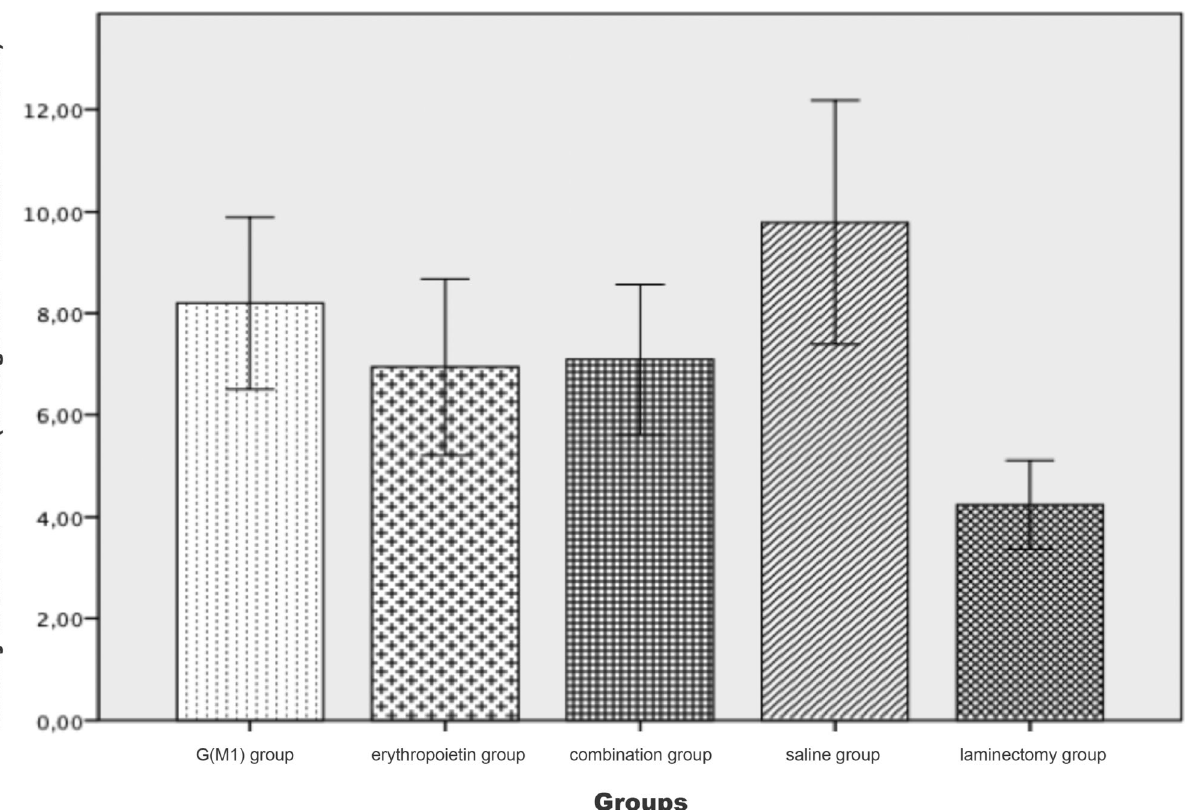
Figure 2 - Latency, as evaluated by motor evoked potential recording, in the lower limbs of Wistar rats subjected to experimental spinal cord contusion lesioning and of control rats not undergoing experimental